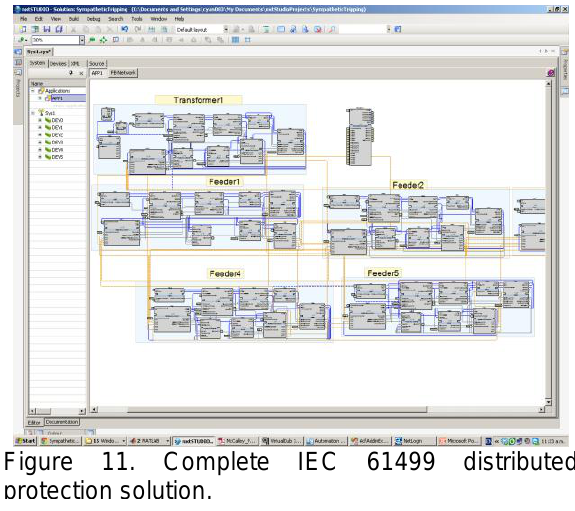
11. Complete IEC 61499 distributed protection solution.